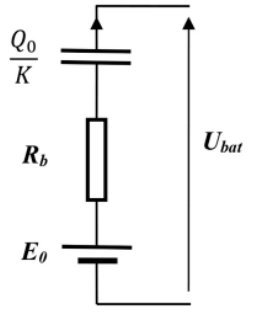
Figure 5. Electrical model of the battery.